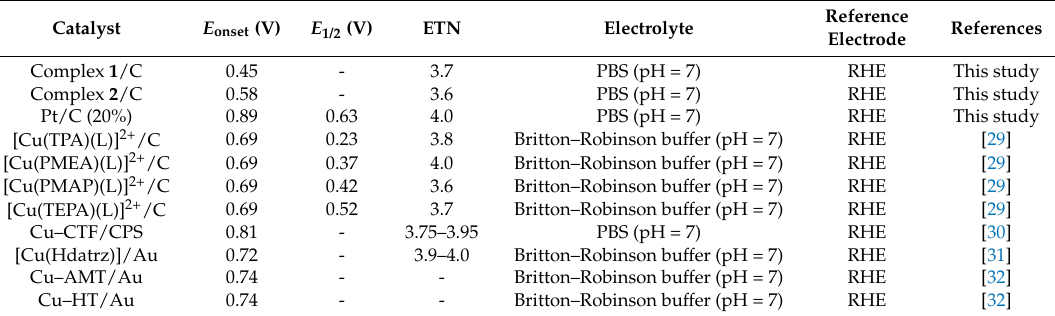
Table 3. Oxygen reduction reaction (ORR) abilities of some M–N x -containing non-noble catalysts reported in recent years. ETN: Electron transfer number; PBS: phosphate buffer solution; RHE: reversible hydrogen electrode.